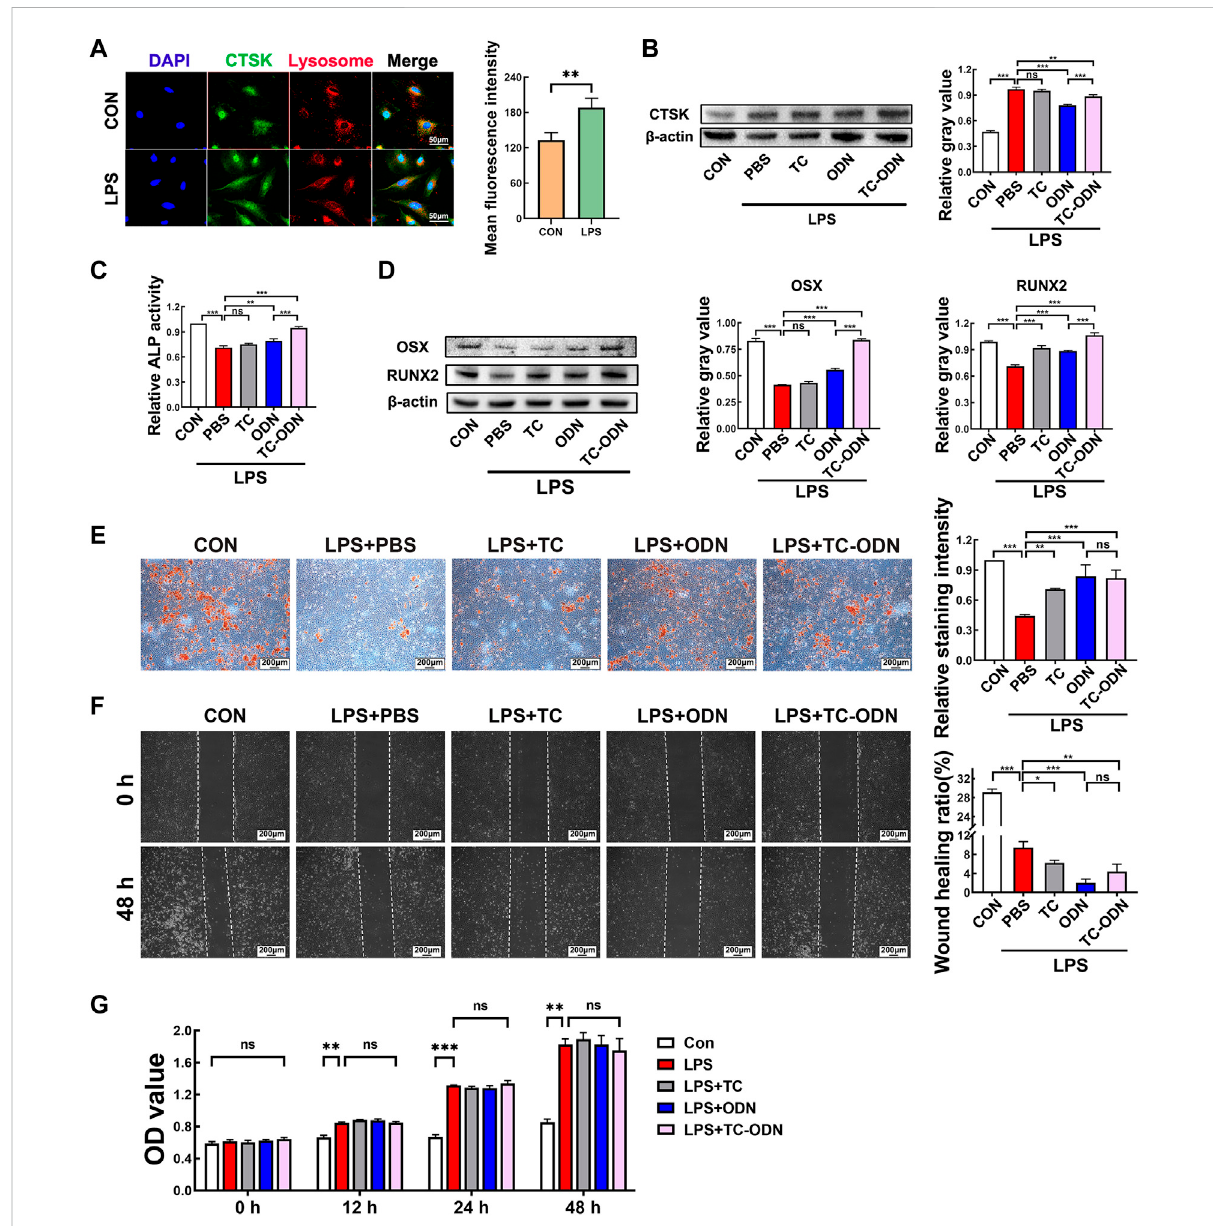
FIGURE 3 Regulation of osteogenetic differentiation of PDLSCs by TC-ODN in an in fl ammatory environment to promote bone regeneration. (A) Representative images of immuno fl uorescence staining to detect theexpression ofCTSK in PDLSCs and the mean fl uorescence intensity ( n = 3). (B) Western blot to detect the expression of CTSK in PDLSCs with different treatments and the semi-quantitative analysis in each group ( n = 3). (C) ALP activity in each group ( n = 3). (D) The expressions of Osterix and RUNX2 in different groups were detected by Western blot after 7 days of osteogentic differentiation ( n = 3). (E) Representative images of alizarin red staining and the relative staining intensity ( n = 3). (F) Representative imagesofthescratchwoundassayandthewoundhealingratio( n =3). (G) CellproliferationassayedbyCCK-8( n =3).Dataarepresentedasmeans± SD. * p < 0.05, ** p < 0.01 and *** p < 0.001 by one-way ANOVA – (B to I) and Student ’ s t-test (A)